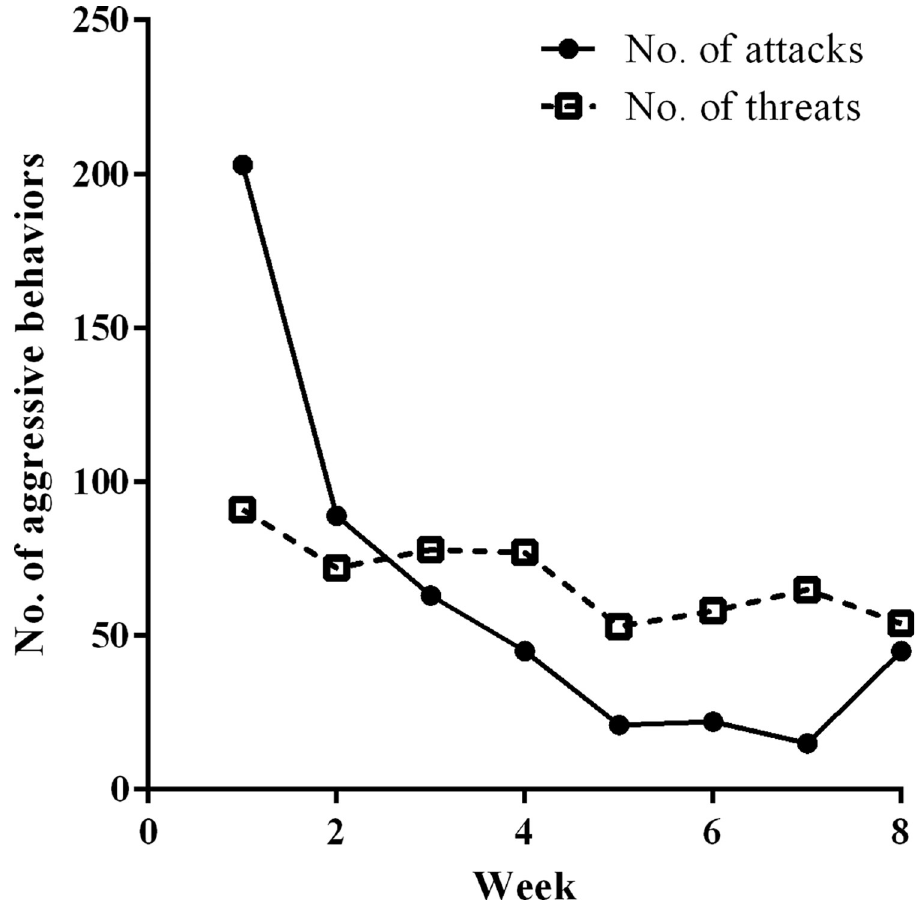
Fig 1. Changes of the number of attack and threat displays by week. https://doi.org/10.1371/journal.pone.0283625.g001 significantly correlated with bill-nose length ( t = 3.05, P = 0.009, B ± SE = 26.10 ± 8.56), but not with other morphological traits or sex (Table 3, Fig 2C and 2D). DS correlated with badge size and sex, with males showing higher scores than females (badge size: t = 2.27, P = 0.041, B ± SE = 0.99 ± 0.44; sex: t = 3.31, P = 0.006, B ± SE = 73.91 ± 22.34), but it